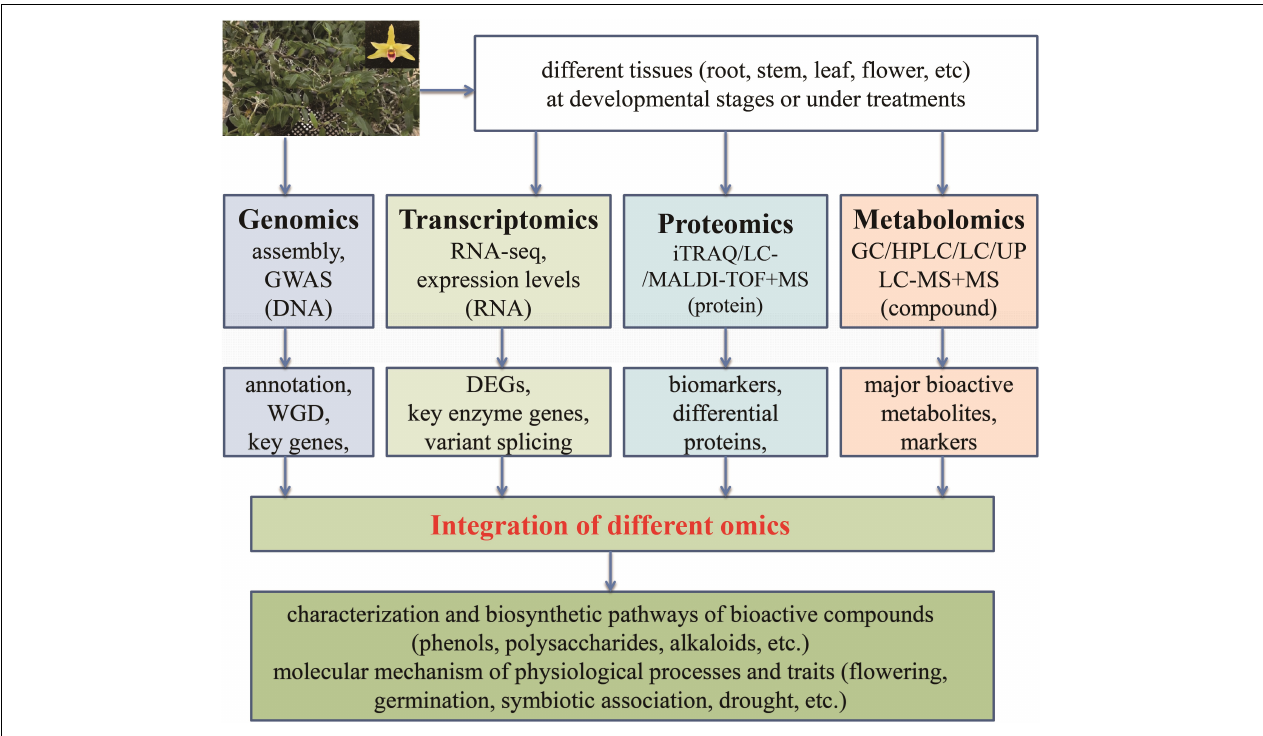
FIGURE 4 | Application of multiple omics in Dendrobium officinale . The integration of data from different levels (DNA, RNA, protein, and metabolites) can make it feasible and reliable to discover the potentially key factors (transcription factor, gene, protein, or compound) responsible for bioactive compounds as well as physiological processes and